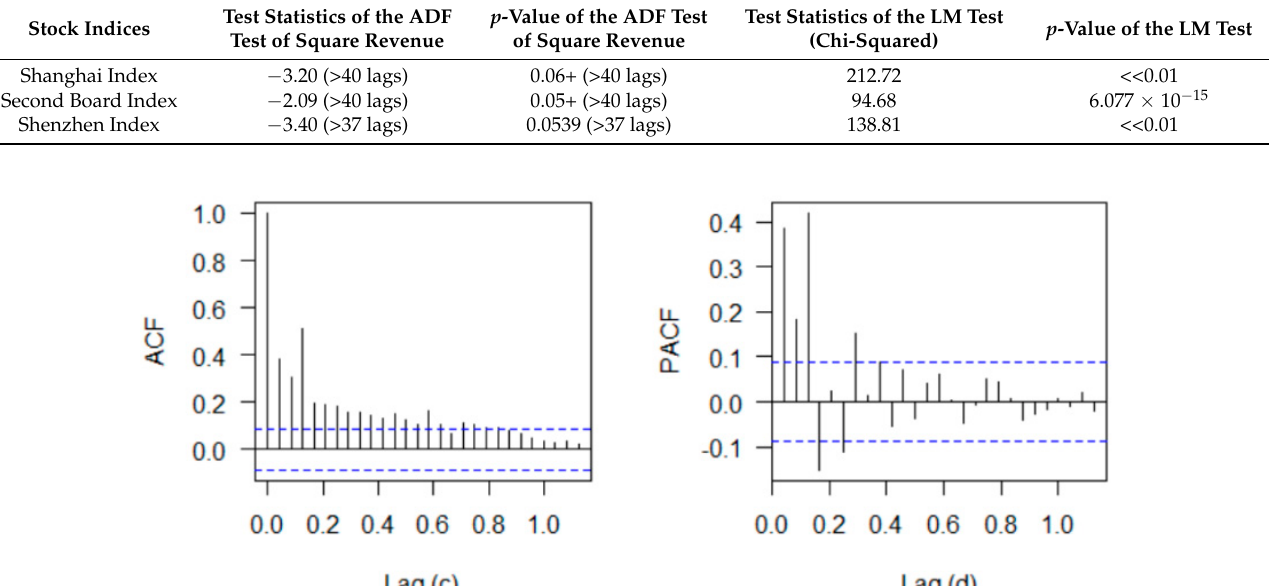
Figure 10. ( c ) Squared ACF plot after the first-order difference of the Shanghai Index. ( d ) Squared PACF plot after the first-order difference of the Shanghai Index.